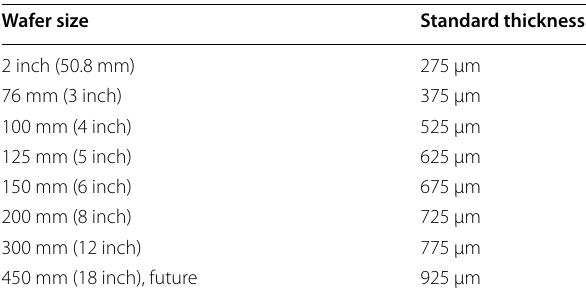
Table 1 Wafer size vs thickness Wafer size